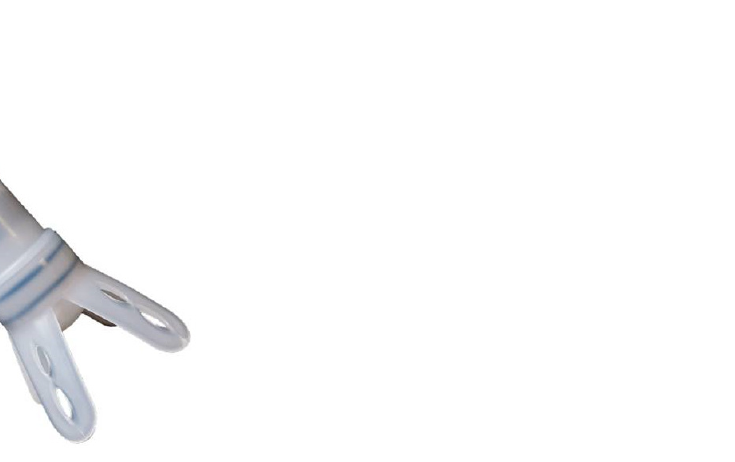
Figure 1. Representation of the intravaginal probe for the calving alarm system. The base works as an anchoring system while the cylindrical bin contains light and temperature sensors, together with a circuit board equipped with a transmitter. The probe is 174 mm in length, the cylindrical bin is 34 mm in diameter and the fin-shaped base is 78.5 mm in diameter. The rounded extremity contains a magnet for communication with the Central Unit.